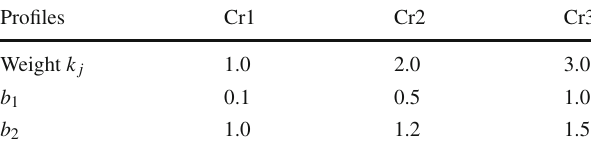
Table 4 Initial profiles and weight defining the category limits